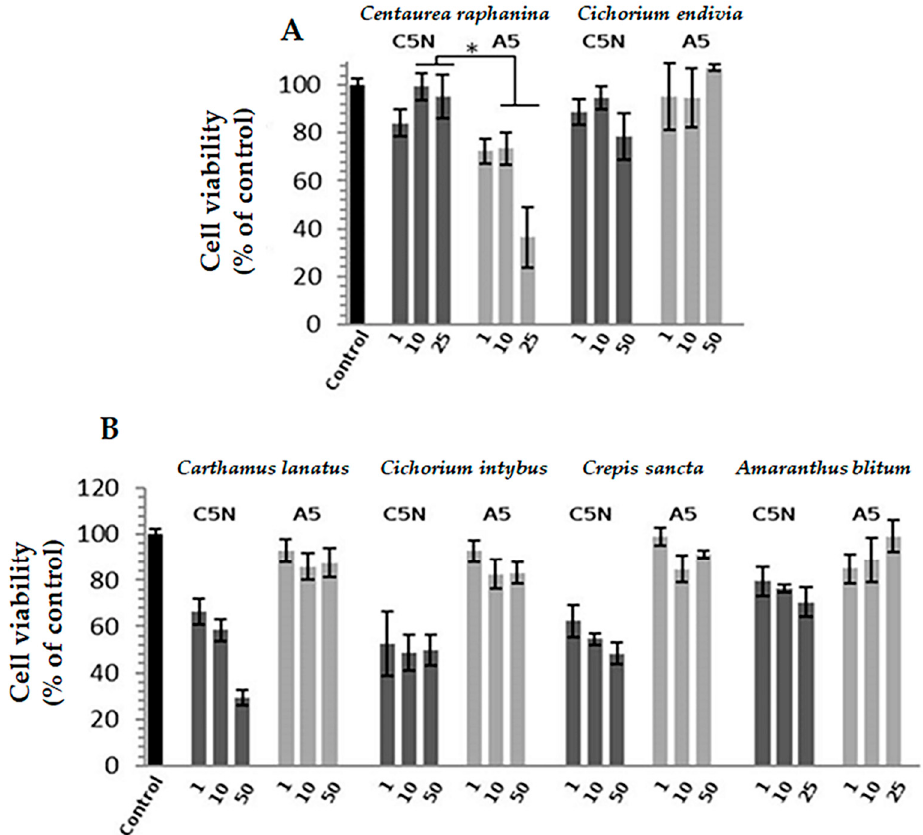
Figure 4. Selected water decoctions of edible chórta and differential toxicity against cancer cells. Comparative toxicities as determined by MTT assay of ( A ) Centaurea raphanina and Cichorium endivia and ( B ) Carthamus lanatus , Cichorium intybus , Crepis sancta , and Amaranthus blitum on C5N and A5 cells following incubation with the indicated concentrations ( μ g/mL) for 72 h. Table 2. Presence (+) or abscence ( − ) of different compound classes in the studied chórta-enriched decoctions and the corresponding half maximal inhibitory concentration (IC 50 ) values determined via DPPH assay.